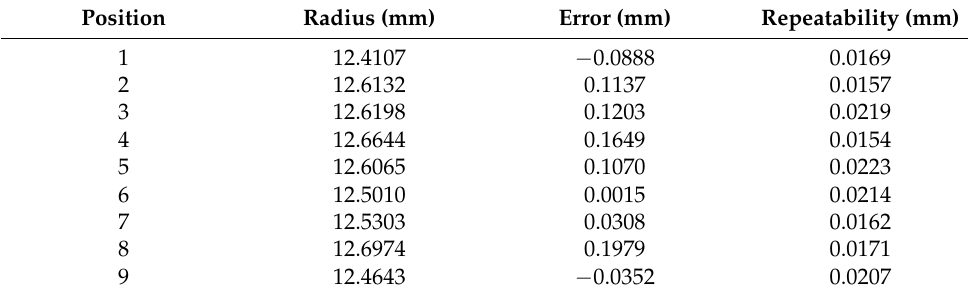
Table 6. Measurement results of the measurement position experiment.